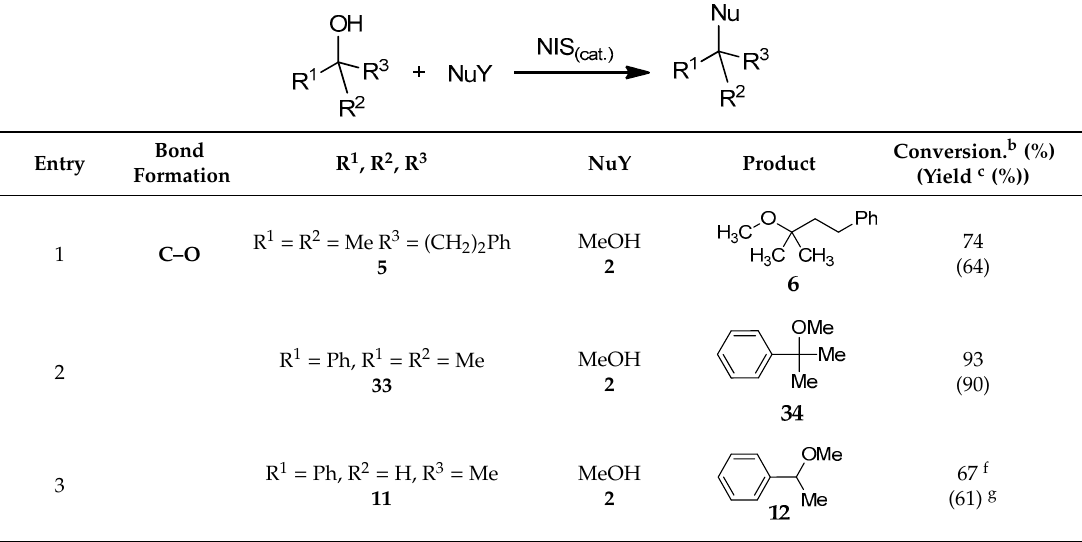
Table 4. Nucleophilic substitution of alcohols using NIS mediator